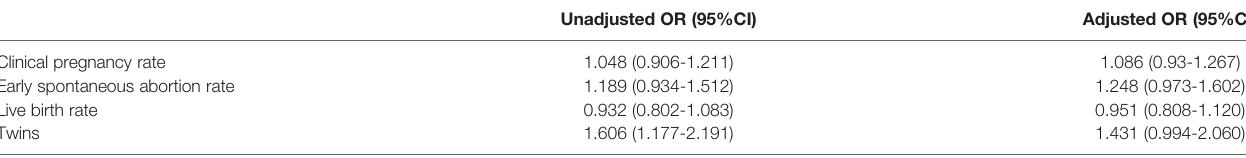
TABLE 5 | Unadjusted and adjusted odds ratios of pregnancy outcomes following L-OI versus HRT cycles.